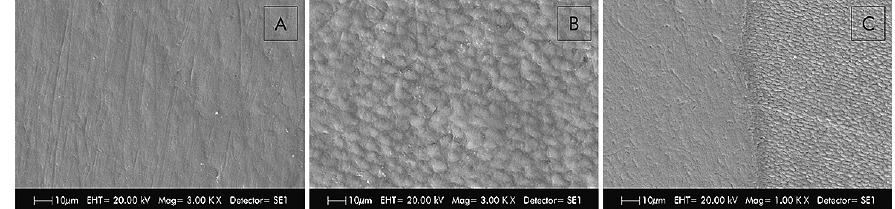
Figure 1- Representative images of scanning electronic microscopy. A- Sound enamel; B- Eroded enamel; C- Image shown the erosive effect only on the surface that did not receive the composite resin as insulation